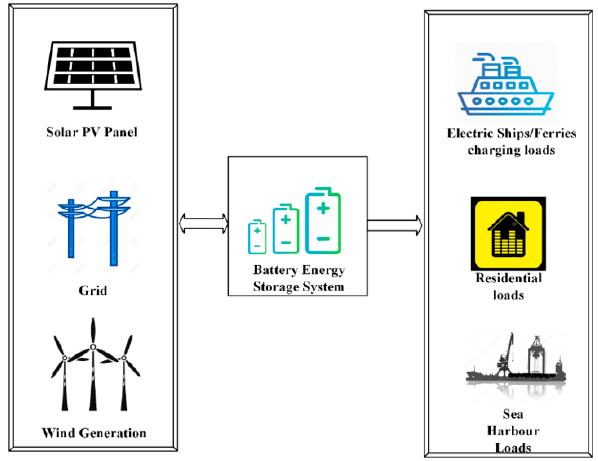
Figure 1. Technologies involved in the method.